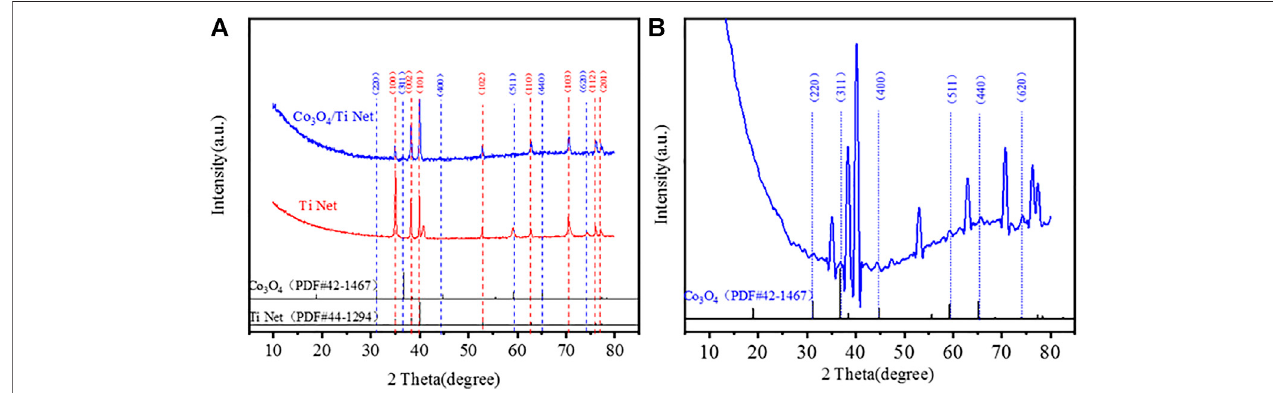
FIGURE 4 | Crystal structure of Co 3 O 4 /Ti cathode and comparison with the reference XRD powder patterns: (A) XRD patterns of Ti and Co 3 O 4 /Ti cathodes; (B) enlarged XRD patterns of Co 3 O 4 /Ti cathode.